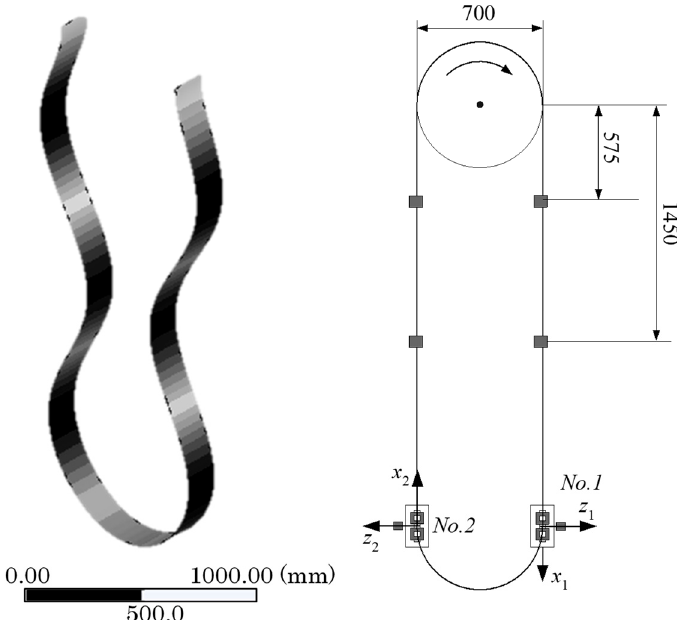
Figure 10. Mode shape and arrangement of permanent magnets.